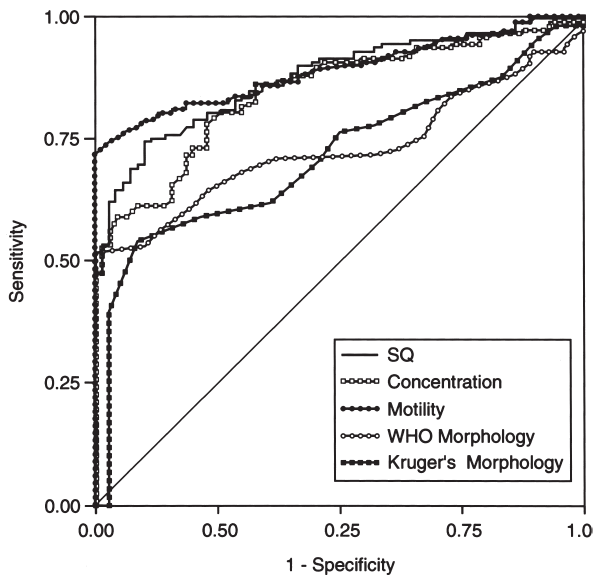
Figure 1 - Receiver operating characteristic curves showing the area under the curve in male factor infertility patients and normal healthy donors utilizing semen quality score and various parameters of sperm quality: (A) semen quality score, (B) concentration, (C) motility, (D) Kruger’s morphology, and (E) World Health Organization morphology